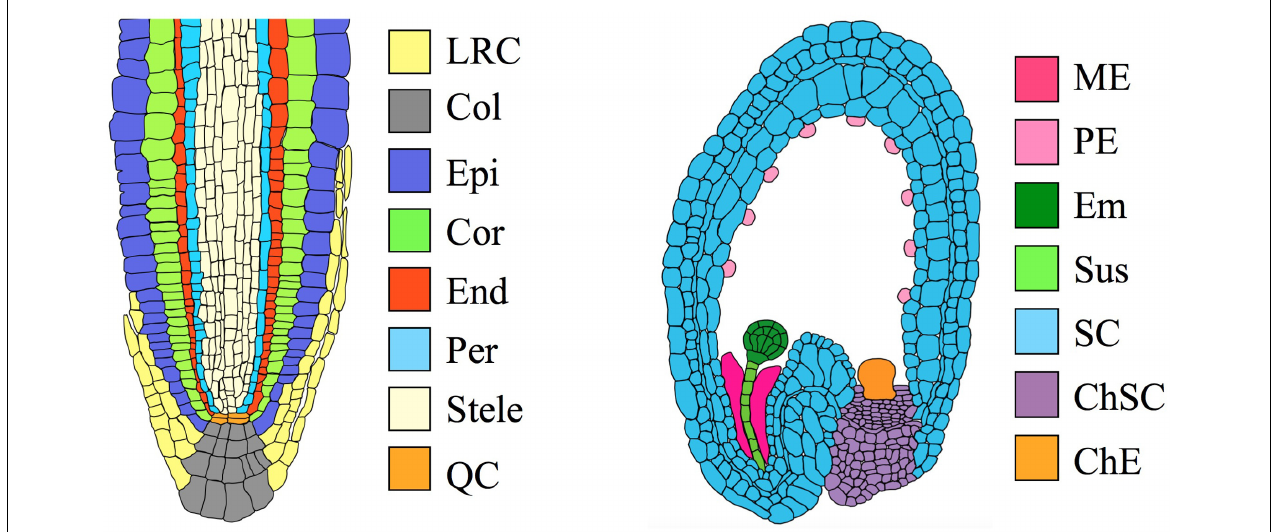
FIGURE 1 | Organs and tissues discussed in this paper. (Left) Transverse section through an Arabidopsis root meristem. LRC, lateral root cap; Col, columella root cap; Epi, epidermis; Cor, cortex; End, endodermis; Per, pericycle; QC, quiescent center. The root has a maximum diameter of ∼ 130 µ m (van der Weele et al., 2000). (Right) Transverse section through an immature Arabidopsis seed, showing an embryo at the globular stage. ME, Micropylar endosperm; PE, peripheral endosperm; Em, embryo; Sus, suspensor; SC, seed coat; ChSC, chalazal seed coat; ChE, chalazal endosperm. The seed has a maximum length of ∼ 500 µ m (Western et al.,